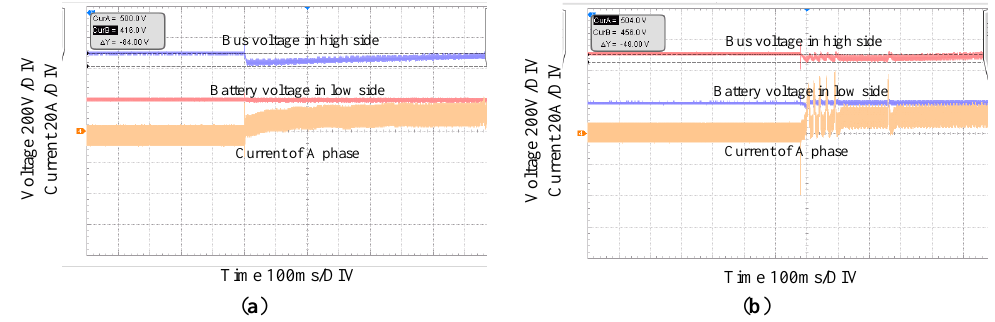
Figure 10. Bus voltage and A-phase current waveform when 11 kW loads are put into the DC bus: ( a